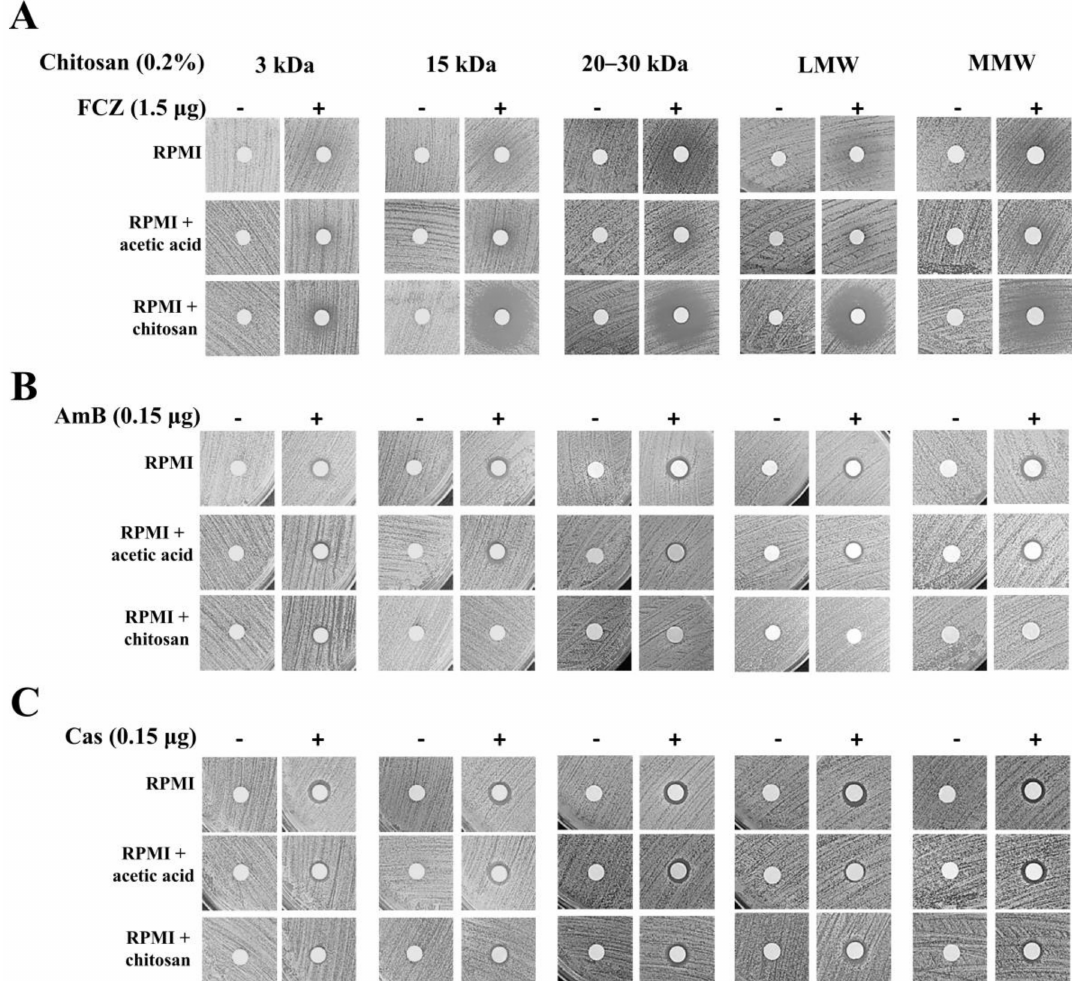
Figure 1. Disk di ff usion assay of each chitosan with or without an antifungal drug against C. albicans 5314. ( A ) Synergistic e ff ects were observed for chitosan in combination with fluconazole (FCZ) against C. albicans SC5314, whereas indi ff erent e ff ects were observed when chitosan was combined with ( B ) amphotericin B (AmB) and ( C ) caspofungin